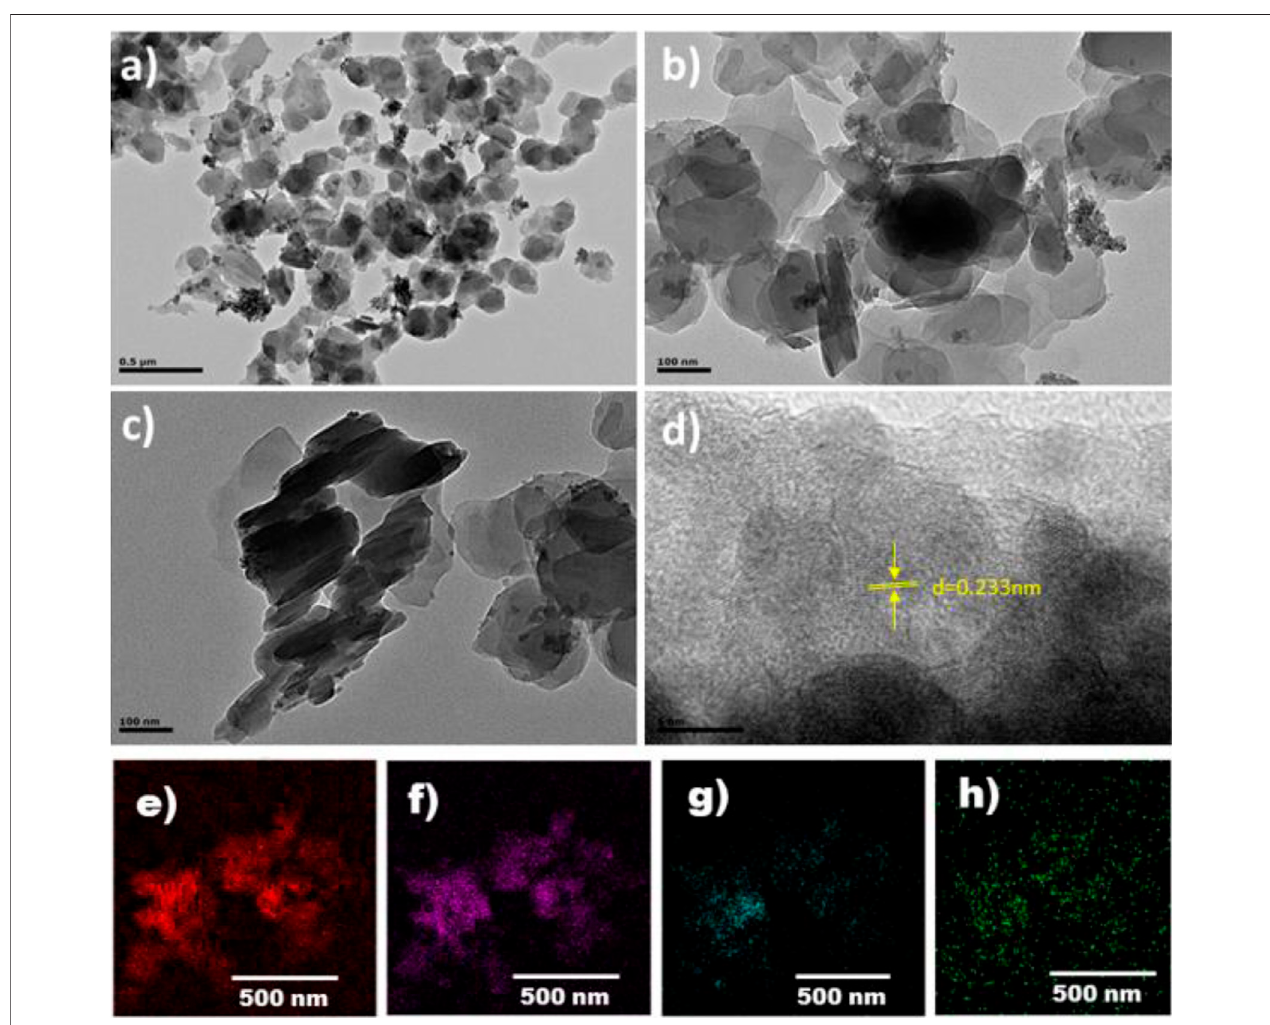
FIGURE 2 | TEM images of composite 1 (A – D) . Elemental mapping with element distributions: carbon (E) , copper (F) , cobalt (G) , and iron (H) .